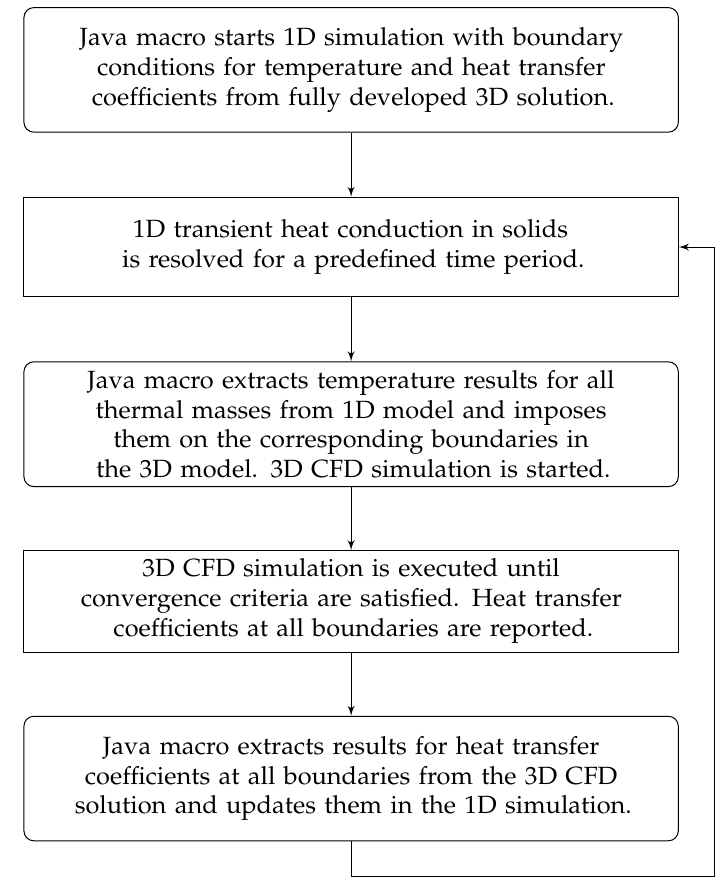
Figure 5. Flow chart describing the coupling procedure between 1D and 3D